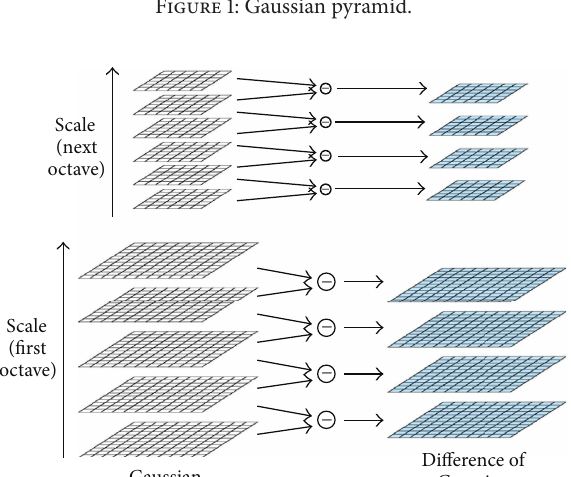
Figure 1: Gaussian pyramid.